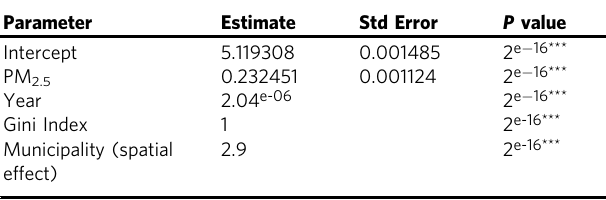
Table 1 Parameter and standard error (Sd) estimates for the entire Amazon-municipalities scale — Spatial model.